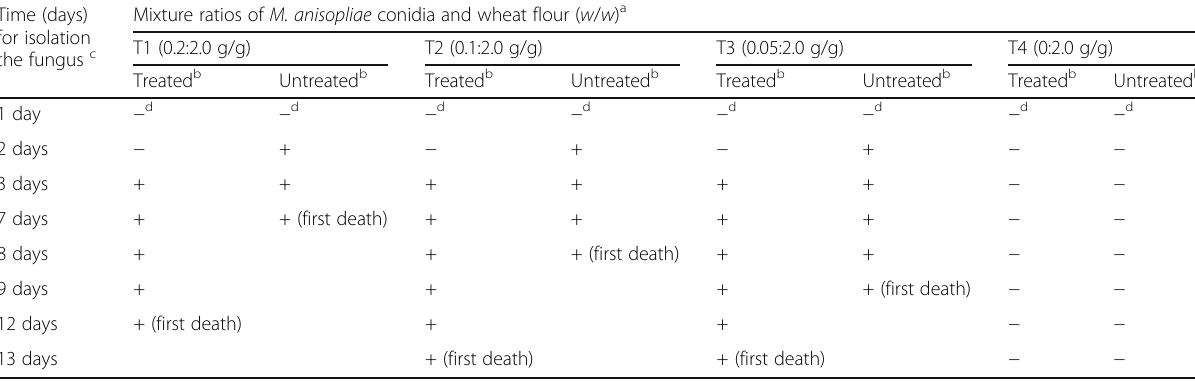
Table 1 Isolation of ingested fungus conidia (or mycelium developing from them) of Metarhizium anisopliae from infected adults of granary weevil, Sitophilus granarius , after feeding them on mixtures of M. anisopliae conidia + wheat flour for 24 h then incubated after surface treatment with Merpan ® on healthy rice grains at 20